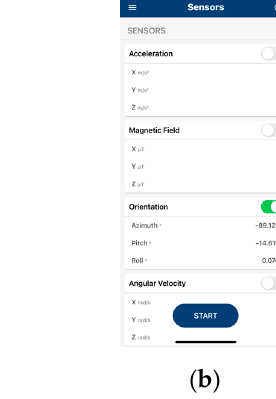
( b ) Figure 3. ( a ) Image capture angle; ( b ) determination of image acquisition position. Using the point-by-point sampling approach, however, a small sample distance re- sults in redundant picture information and a greater database size, which increases the retrieval complexity and time consumption. Excessive sampling spacing will lead to the lack of image information and coordinate information for some scenes in the visual map, limiting the accuracy of image retrieval or even making it impossible, resulting in the in- ability to achieve positioning in the online stage. As a result, and based on epipolar geom- etry, this paper proposes a visual map construction method that uses feature point match- ing, so as to determine the optimal sampling interval within the constraints and effectively control the scale of the database. As shown in Figure 4, the relative positional relationship between the query camera and the database camera can be estimated according to the epipolar geometry.